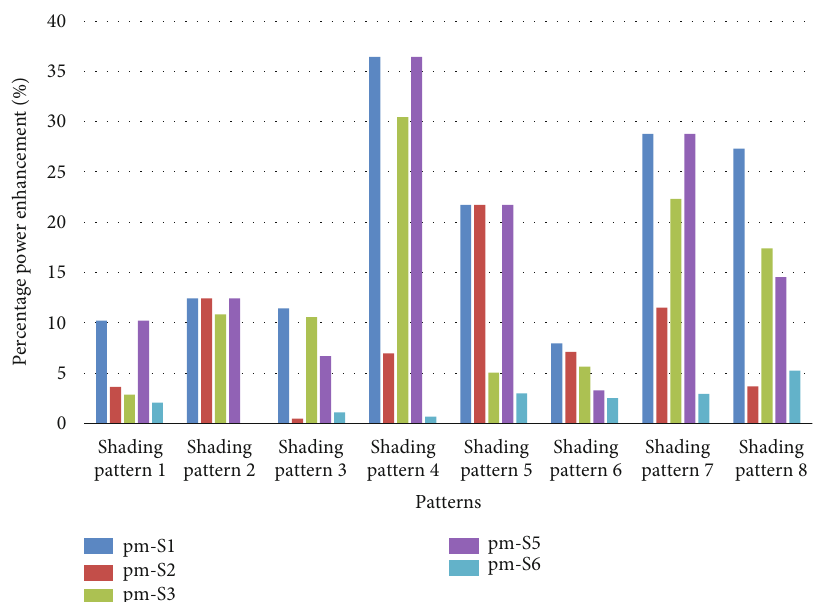
Figure 19: Power enhancement of the proposed method and structures 1-6 under di ff erent shading patterns. Table 5: Numbers of switches/sensors required in the proposed method and a 10 × 10 dynamic recon fi guration. Method Current sensors Voltage sensors Switches Dynamic recon fi guration method in Ref. [11] The proposed